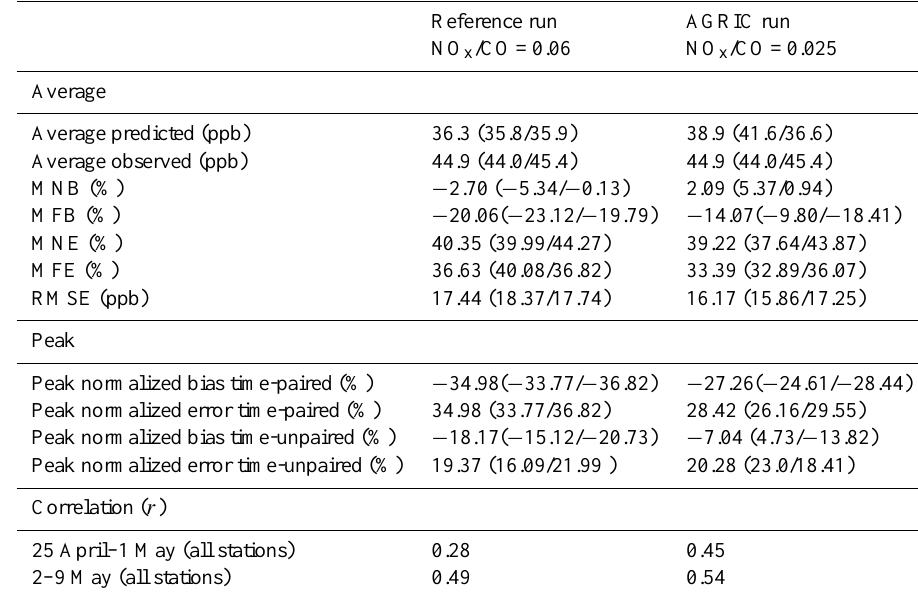
Table 2. Statistical performance for O 3 over all rural background monitoring stations of the EMEP network (stations of Northern Eu- rope/stations of Central Europe). All the predicted-observed pairs are